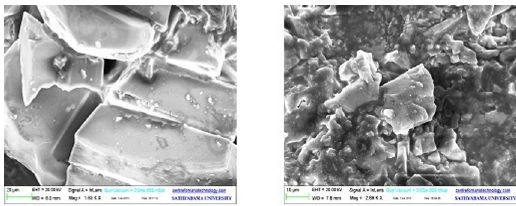
Figure 4. FESEM images of MMTG crystal